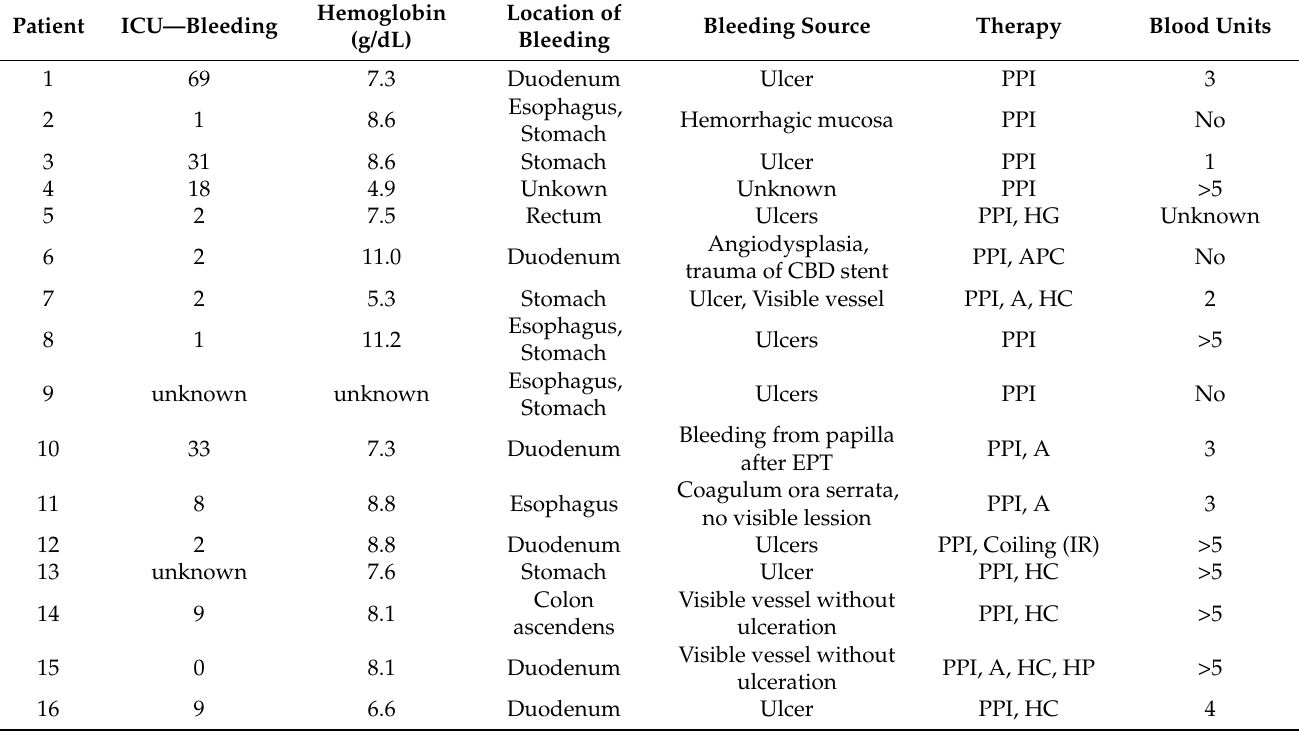
Table 4. Characteristics of GI bleeding in SC-CIP patients. All patients with GI bleeding were numbered from 1 to 16. Patient 13 died because of GI bleeding. In all other 15 patients, GI bleeding was not lethal. ICU—bleeding is the time from admission to ICU to the onset of gastrointestinal bleeding in months. Hemoglobin levels were documented at time of diagnosis of gastrointestinal bleeding.